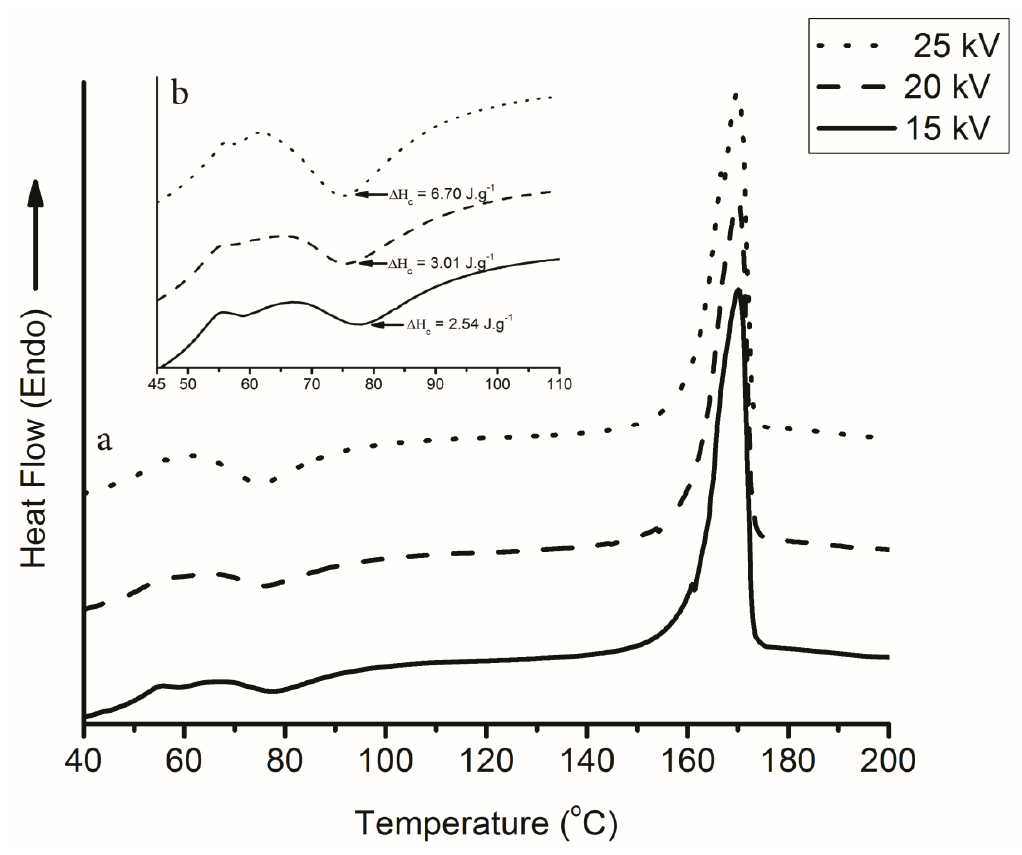
Figure 6. ( a ) DSC scans of fibers electrospun from 5 wt% solution at a constant NTCD of 10 cm and varying voltages; ( b ) Cold crystallization region of scans shown in A.